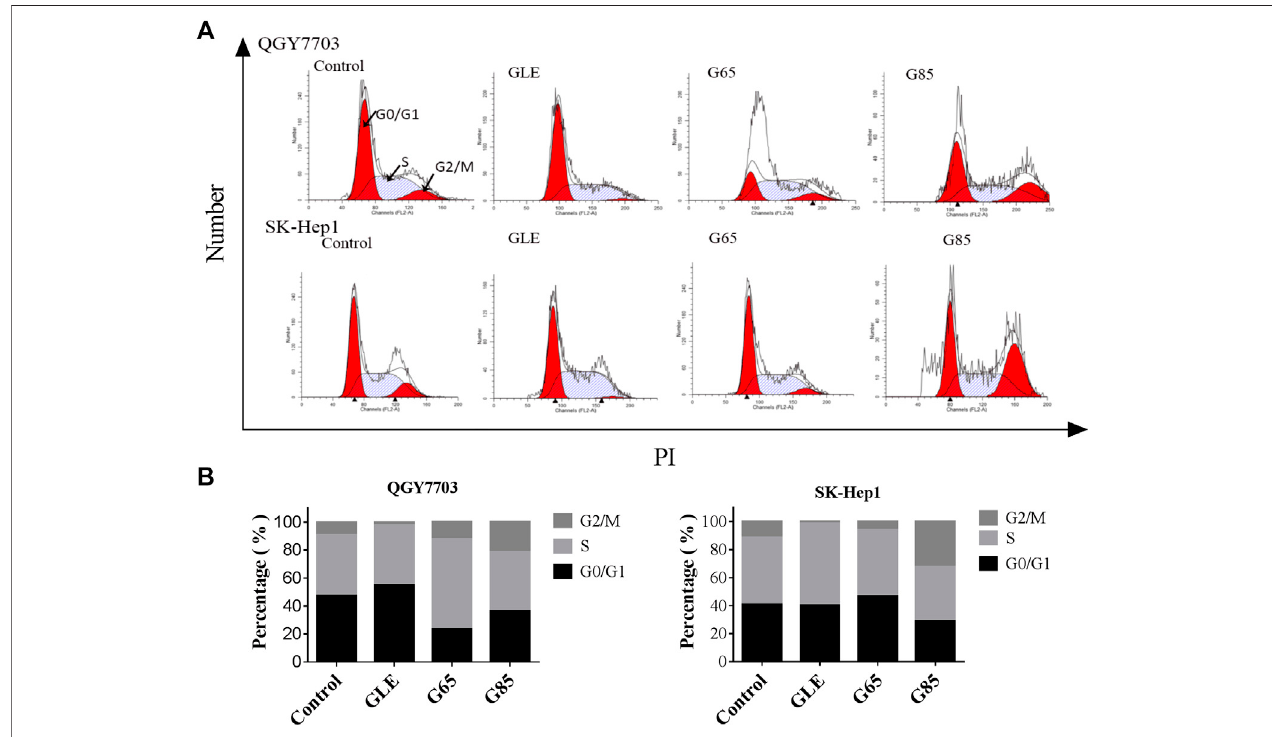
FIGURE4| G.lucidum extractsarrestedcellcycleinG2/M. (A) QGY7703andSK-Hep1cellstreatedwithGLE,G65,andG85(150 μ g/ml)for24 h,ethanol fi xationand PIsingle staining were performed, and cellcycle was detected by fl owcytometry. (B) PercentageofQGY7703and SK-Hep1 cells indifferent cellcycle phaseswas shown.